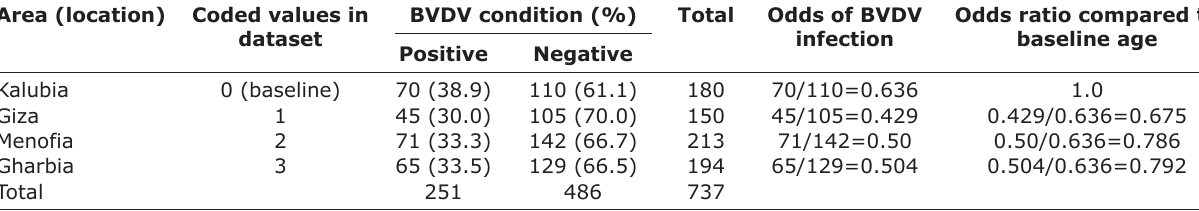
Table-4: Chi-square test for the association between BVD prevalence and localities. Area (location)